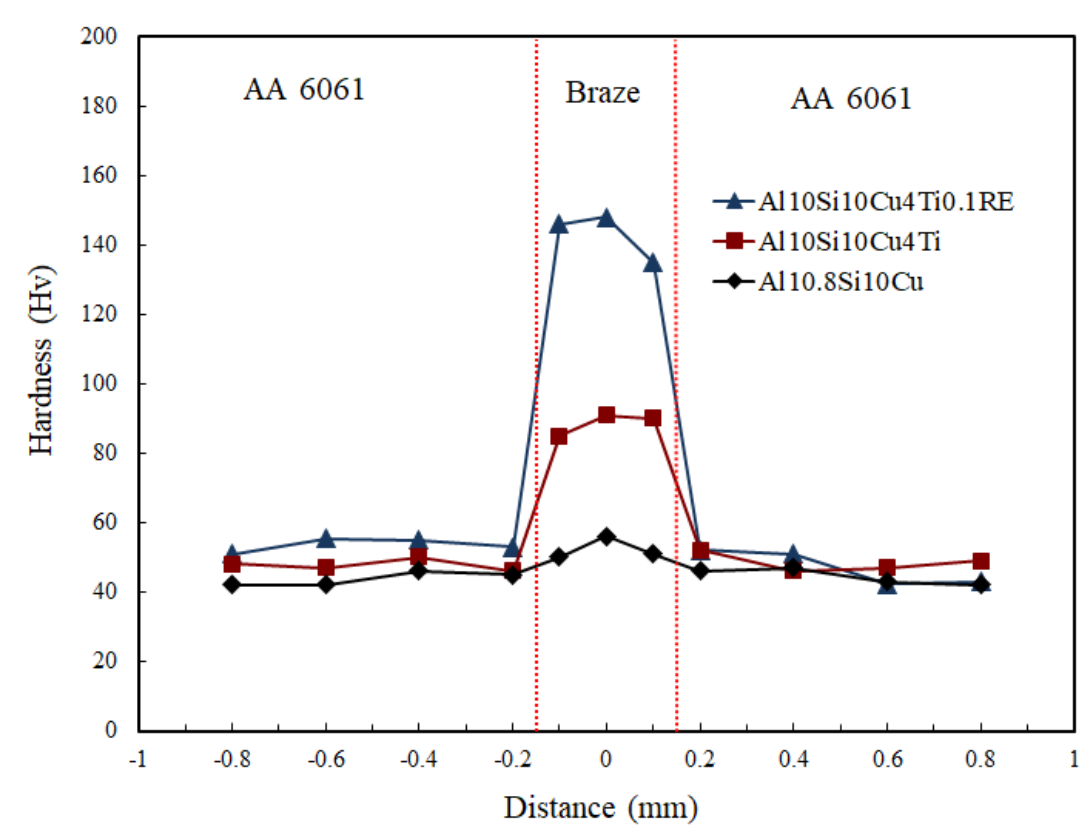
Figure 7. Microhardness profiles for the interfaces of AA6061/AA6061 joints brazed with Al10.8Si10Cu, Al10Si10Cu4Ti and Al10Si10Cu4Ti0.1RE filler alloys at 530 °C for 10 min.